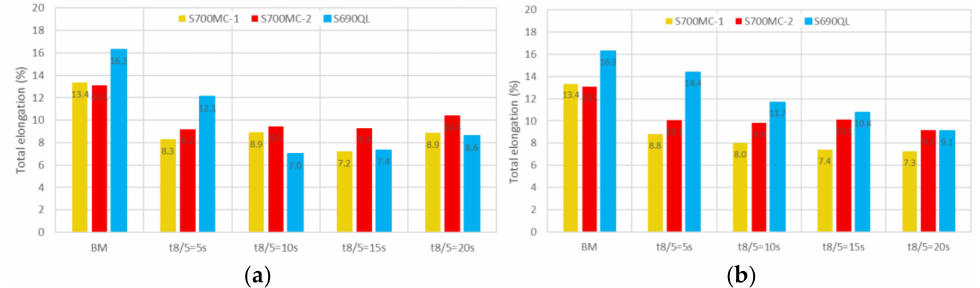
Figure 5. Elongations of the welds: ( a ) machined specimens; ( b ) specimens with reinforcements.